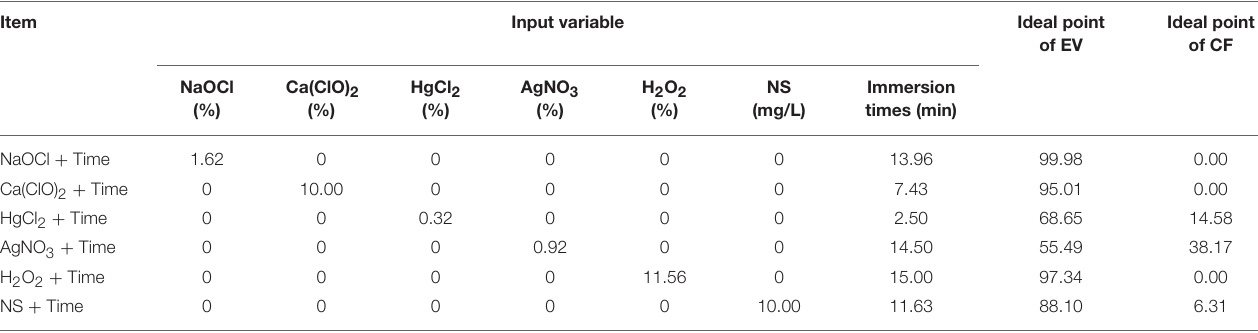
TABLE 8 | Optimizing sterilants and immersion times according to optimization analysis on the developed MLP-NSGAII in the ideal point for contamination frequency (CF) and explant viability (EV) in chrysanthemum. Item